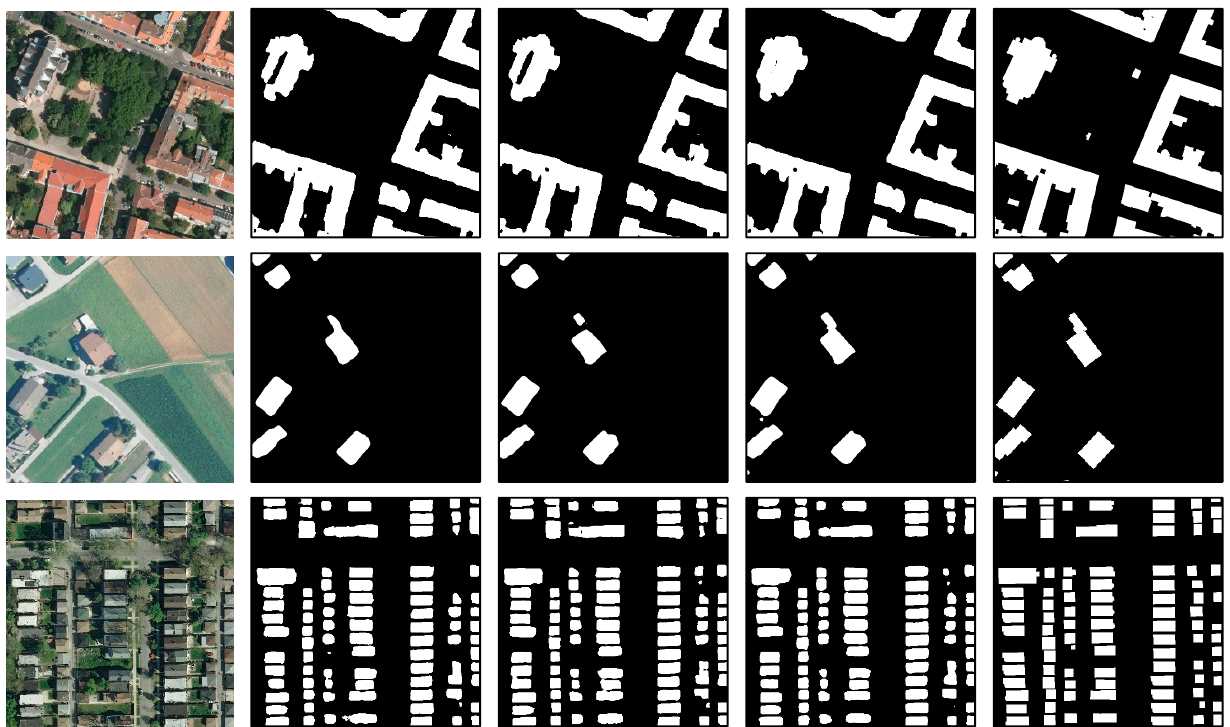
Figure 8. Visual comparisons of building-extraction results on the ISPRS Vaihingen data set by different models. ( a ) Input image, ( b ) FCN, ( c ) Deeplabv3+, ( d ) MAPNet, ( e ) the proposed DMBC-Net, and ( f ) Ground truths of the input image.